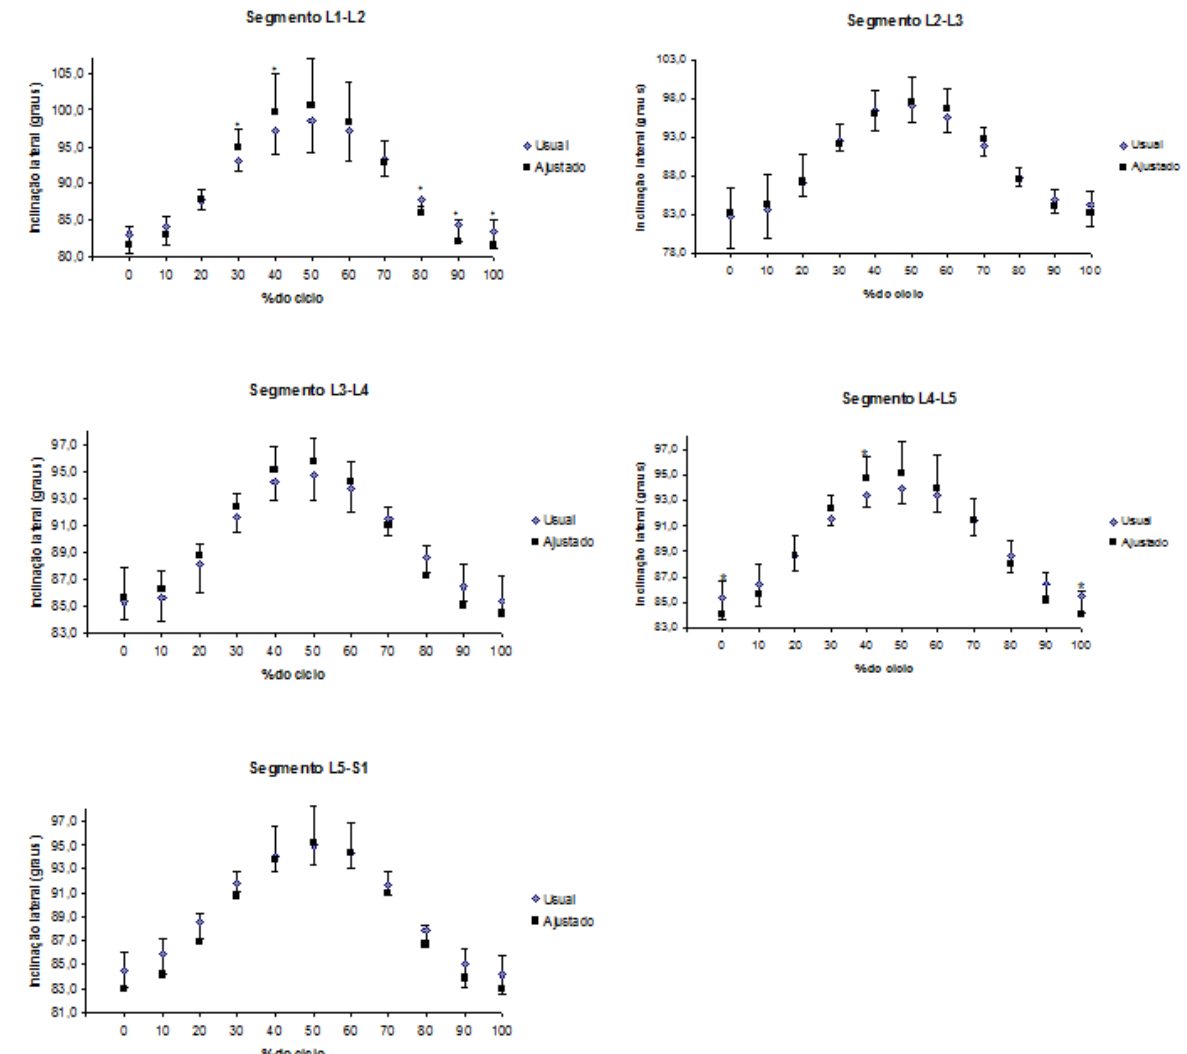
Figura 4. Comparação dos resultados de inclinação lateral da coluna lombar nas duas posições adotadas. * p<0,05 representa valor estatisticamente significativo ( Bonferroni ) entre as situações de selim ajustado e